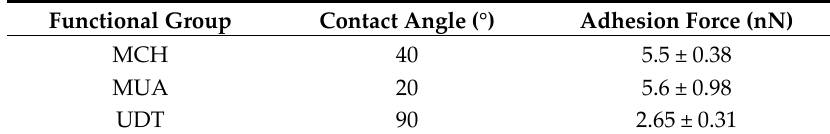
Table 1. Adhesion force and contact angle between silicon tips and different chemical groups; alcohol (MCH), carboxyl (MUA) and alkyl (UDT)